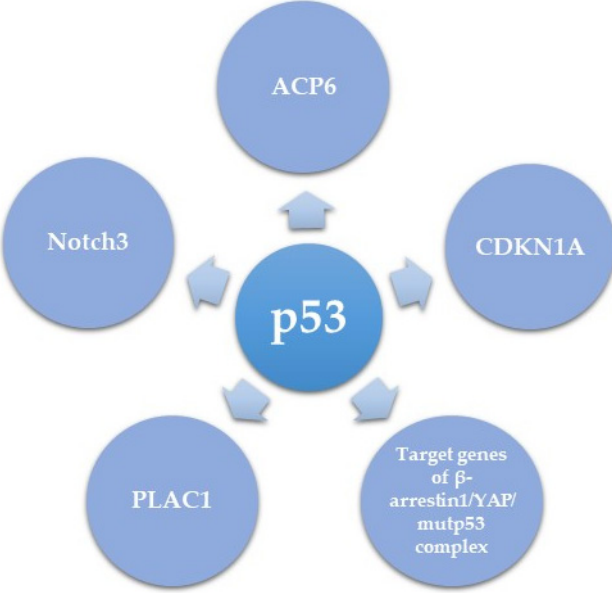
Figure 3. Downstream mediators of mutant p53 function .